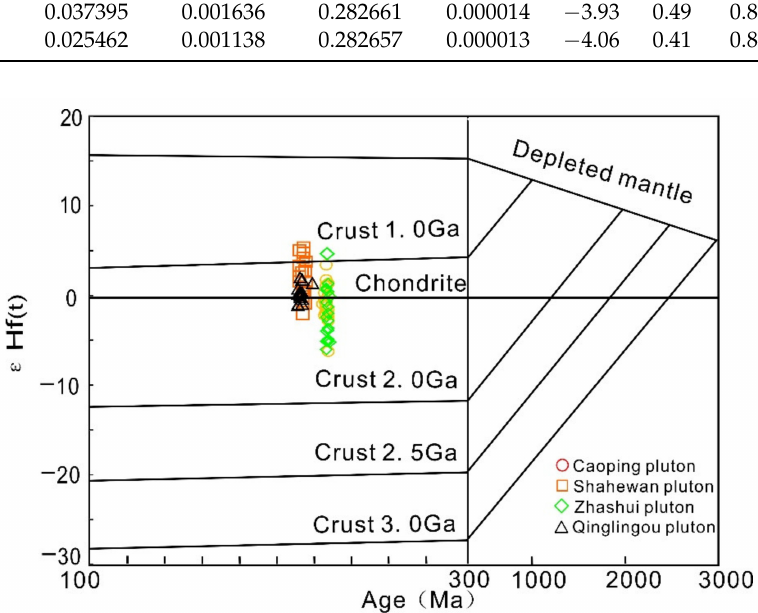
Figure 8. Plot of zircon ε Hf (t) values vs. crystallization ages for the granite porphyry from the Qinglingou Au deposit. Other granitoid data in the Zhashui-Shanyang district are from